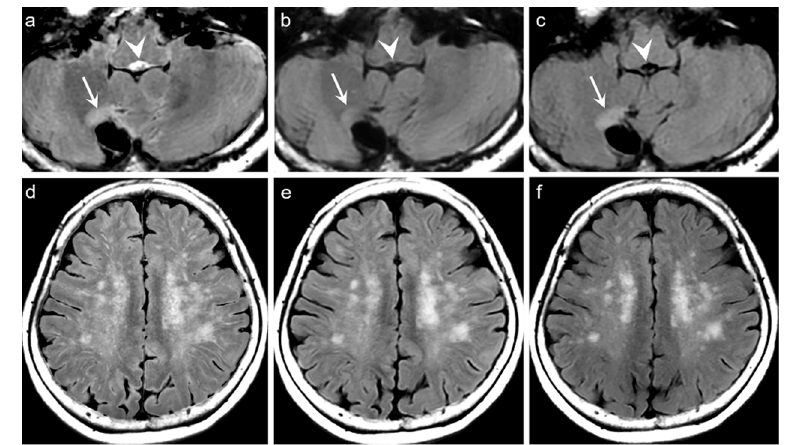
images are shown (a–d). ( a ) Surface hyperintensity artifacts (arrowheads) and cortical swelling artifacts (arrows) on synthetic FLAIR are almost removed on DL-FLAIR image. ( b ) Cortical swelling artifacts (arrows) on native synthetic FLAIR are successfully removed on DL-FLAIR image. ( c ) Periventricular hyperintense artifacts along the margin of bilateral lateral ventricles (black arrows) and surface hyperintensity artifacts (white arrows) on the native synthetic FLAIR are successfully eliminated on DL-FLAIR image. ( d ) Flow artifacts in the prepontine cistern (white arrows) and surface hyperintensity artifacts along the pons (white arrowheads) on the native synthetic FLAIR are improved on DL-FLAIR image.